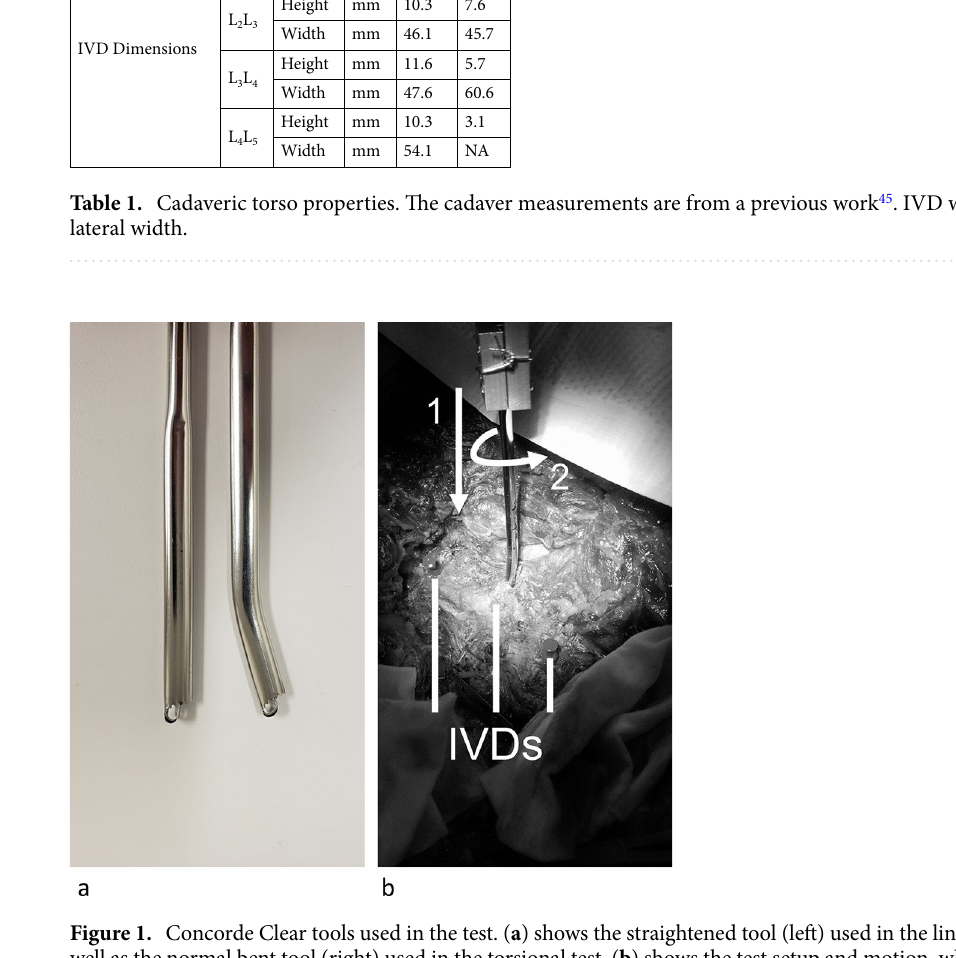
side of C1 L 3 L 4 . Torsional speeds of 10, 20, 30, and 40°/s were compared on the right side of C1 L 4 L 5 . Test details are shown in Table 2.